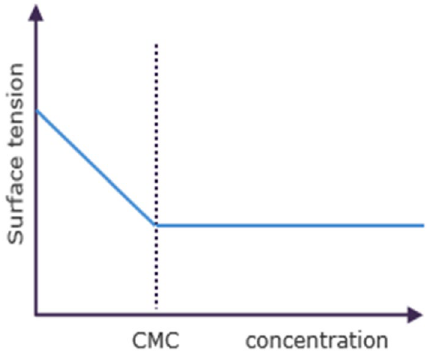
Fig. 1 Schematic of the concentration dependence of surface tension for the solution of a micelle-forming